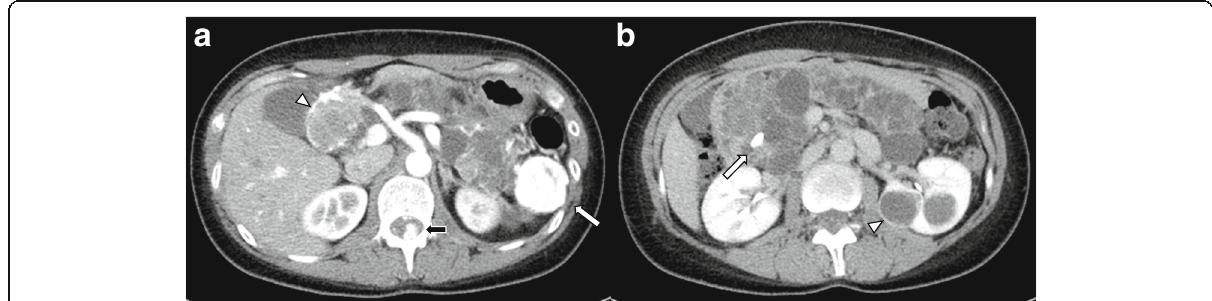
Fig. 1 a Abdominal computed tomography showed a well-enhanced mass, 4 cm in diameter, in the tail of the pancreas ( white arrow ) and multilocular tumors in the head of the pancreas ( arrowhead ). One small, enhancing focus was seen in the spinal canal at the L1 level ( black arrow ). b The pancreas was completely replaced with mixed microcystic and macrocystic serous cystic neoplasms. Several calcifications of the pancreas ( arrow ) and renal cell carcinoma ( arrowhead ) were observed